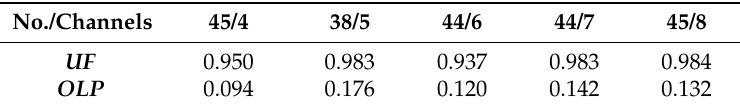
Figure 6. Transmittance curves of the verified best-performed filter sets under CIE standard illuminant D65 at 4, 5, 6, 7and 8 channels (No. 45, 44 and 38) and the filter set series with maximum ℓ (cid:2870) norm first filter (No. 2), where the first filter of the filter sets is graphed in bold line with solid round markers. The filter sets are selected the same way as the traditional MLI algorithm charted in Section 2 by minimizing condition number at each channel with the designated filter as the first filter of the corresponding filter set. The notation, for example, No. 38 (5 channels) denotes the No. 38 filter set is superior to others when the number of channels is 5, and the No. of the first filter of the filter set is 38. Table 5. The geometric measurements of the best-performed